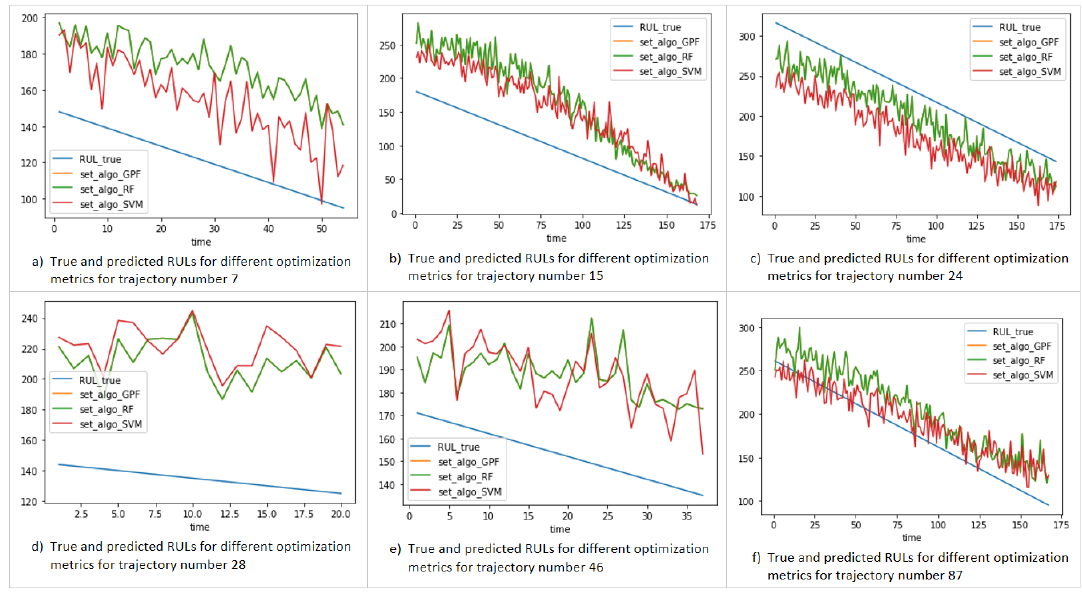
Figure 13. True and predicted value on dataset FD004 for six different trajectories when using the GPF, RF, and SVM.